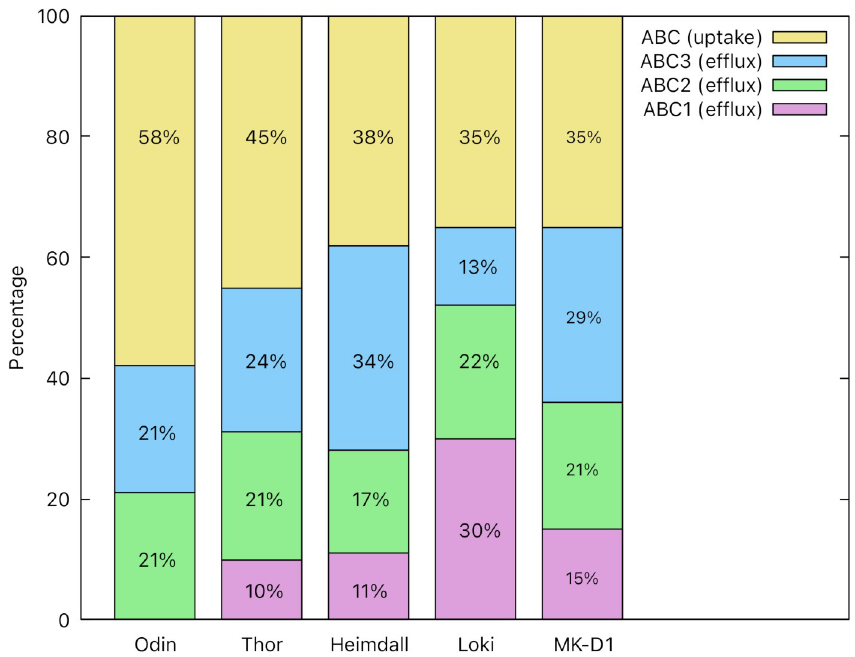
Fig 3. ABC types encoded within the five Asgard proteomes. The percentages of efflux and uptake ABC transporters are shown for all Asgard proteomes. Note that a) efflux systems predominate in all Asgard proteomes, b) ABC1 efflux systems were not detected in Odin, and c) Loki has the only MAG in which we identified more ABC1 systems than ABC2 or ABC3 systems.